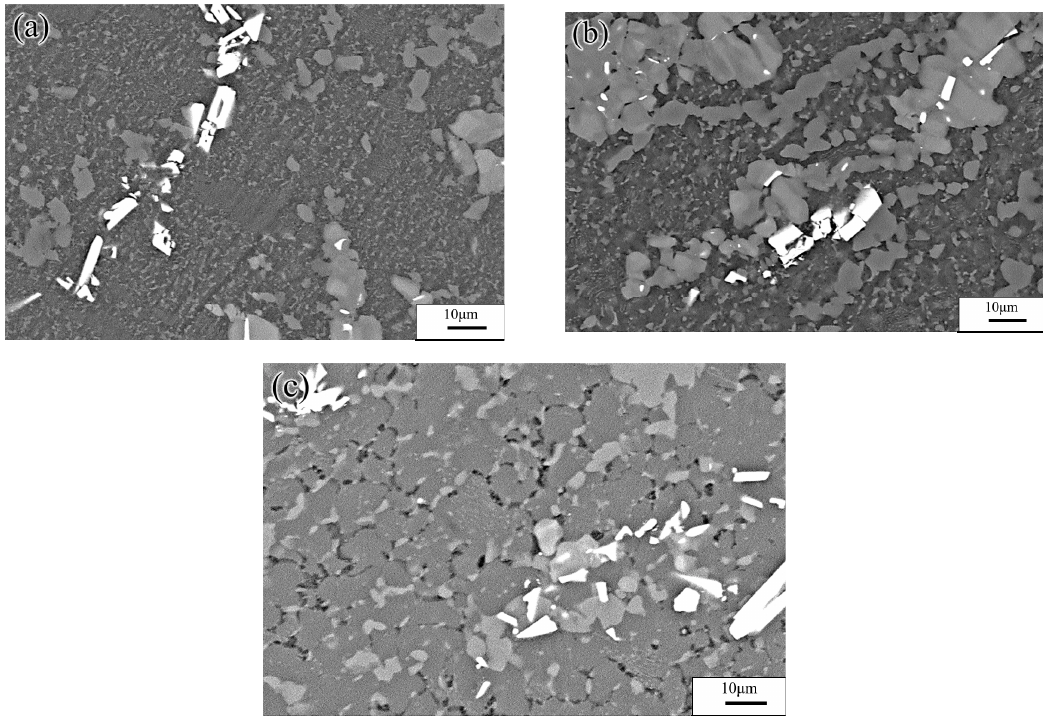
Figure 20. SEM images of the Mg-16Al Mg alloy in change-over region: ( a ) 573 K / 0 0.01 s − 1 , ( b ) 573 K / 0 0.001 s − 1 and ( c ) 623 K / 0 0.001 s − 1 .